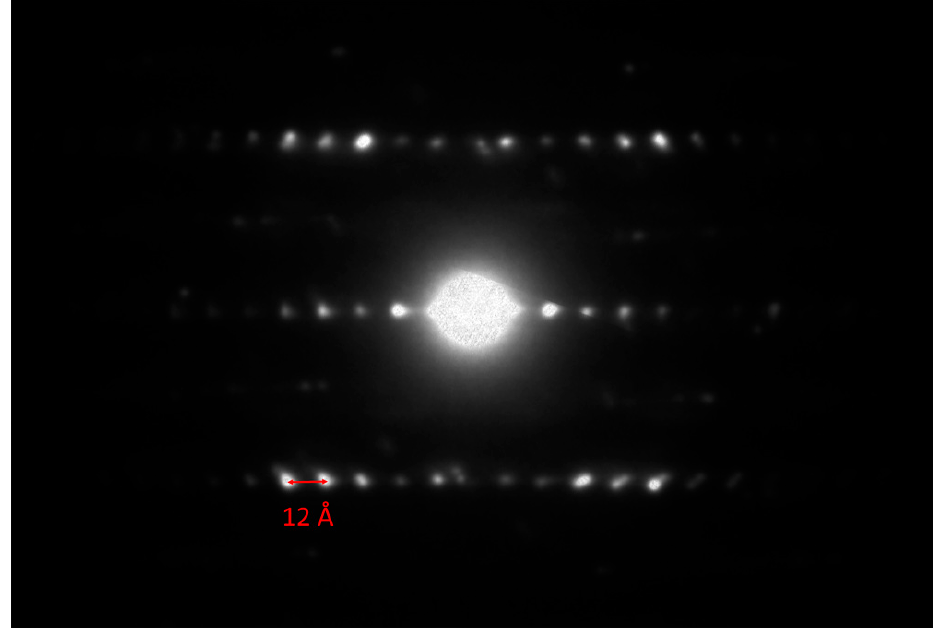
Figure 12. Selected area electron diffraction pattern down [010] of merelaniite. The c -stacking corresponding to ≈ 12 Å is shown. (Sample 3666qx A grid A2.).